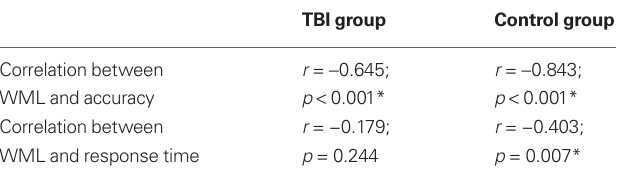
Table 3 | Within-groups performance